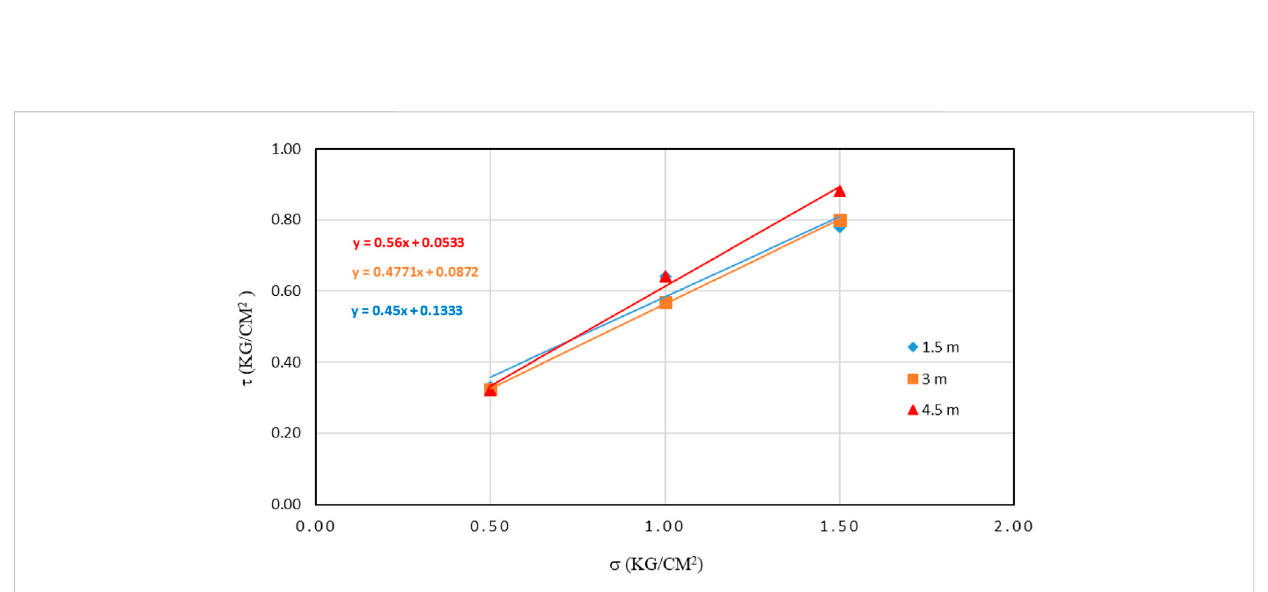
FIGURE 10 Shear strength results for natural soil at different depths.